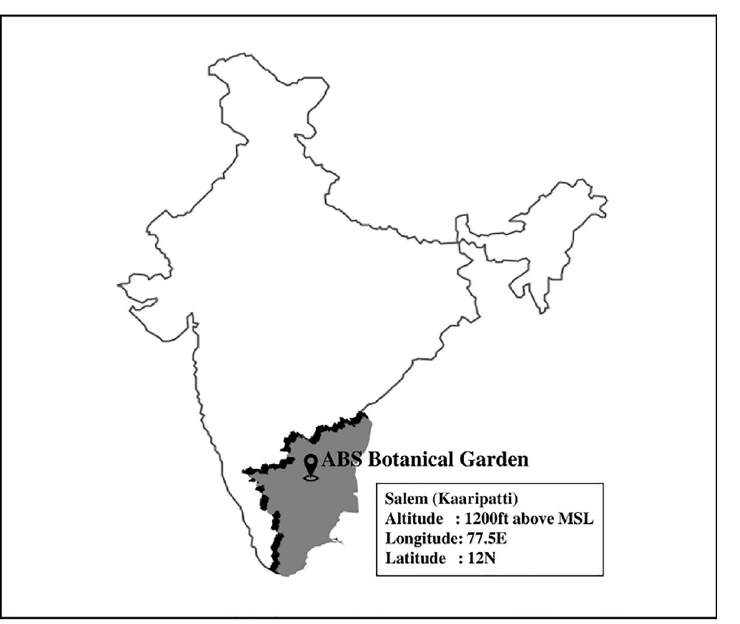
Fig 2. Map showing the geographical location of the sampling